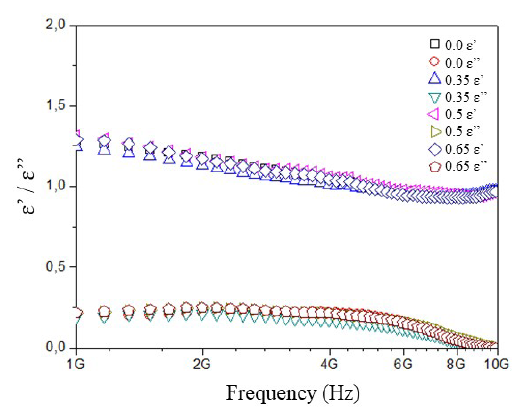
Figure 9. Permittivity versus Frequency for blankets with Mn